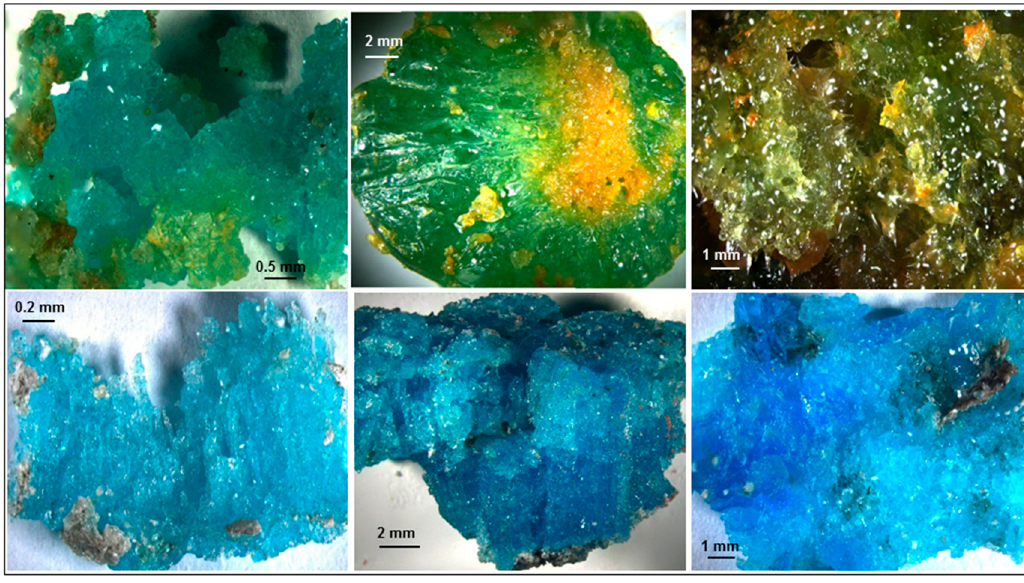
Figure 13. Stereomicroscope images of melanterite.